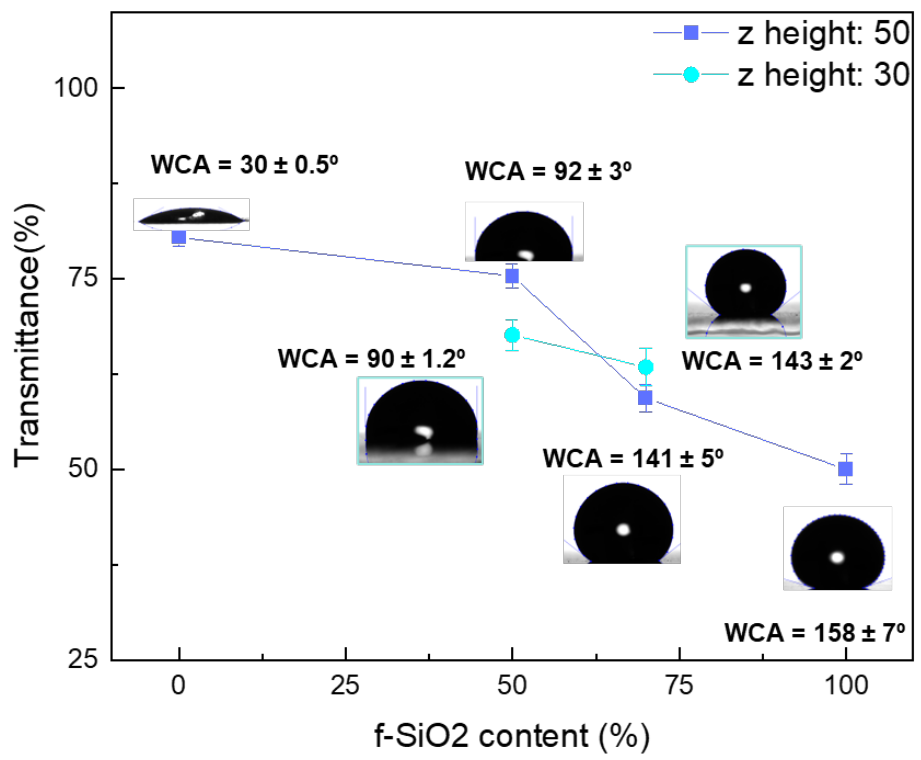
Figure 8. Value of average transmittance of the coating varies with the content of f-SiO 2 the with the corresponding WCA images at two different spraying distances — 30 mm and 50 mm.